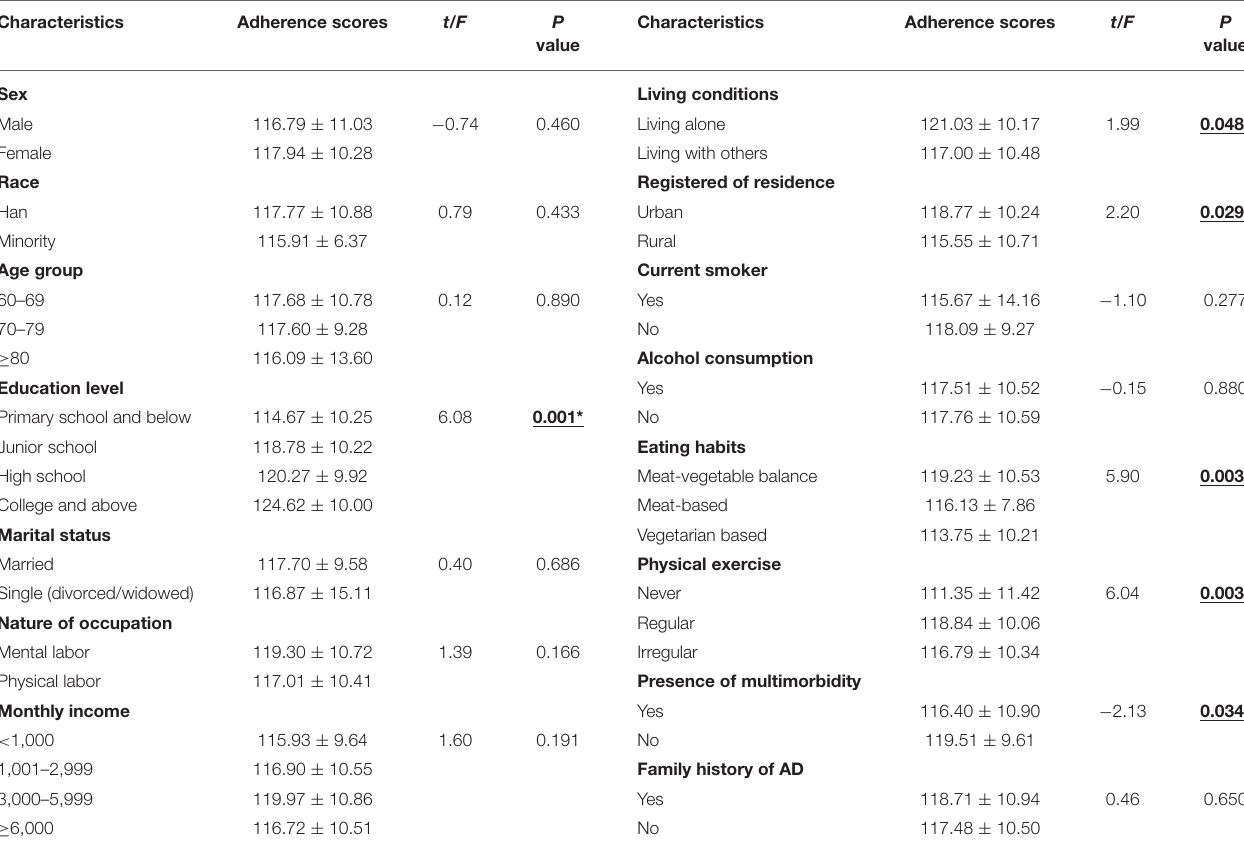
TABLE 2 | Univariate analysis of adherence of cognitive dysfunction management ( N = 216). Characteristics Adherence scores